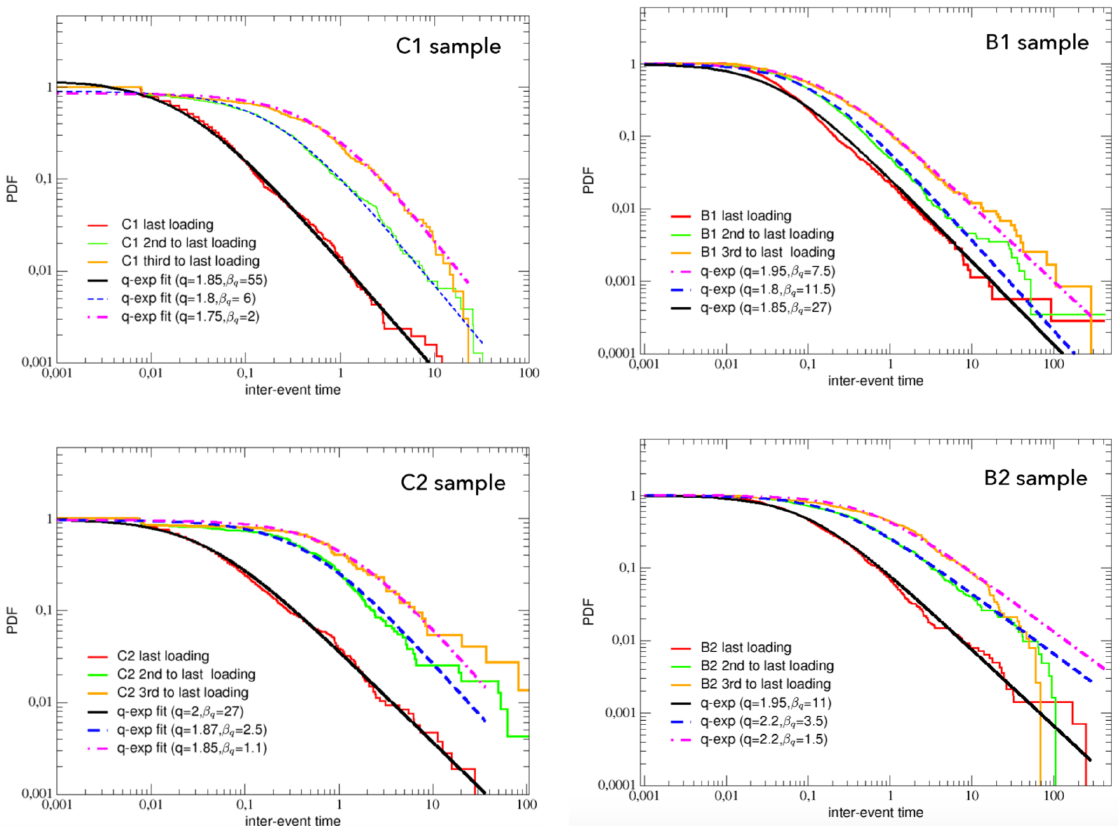
Figure 28. Cumulative pdfs of the inter-event times of acoustic emission for the last three loadings of the specimens. Left : C1, C2 (concrete) and Right : B1, B2 (basalt). The q -exponential fittings are also shown. From [139].